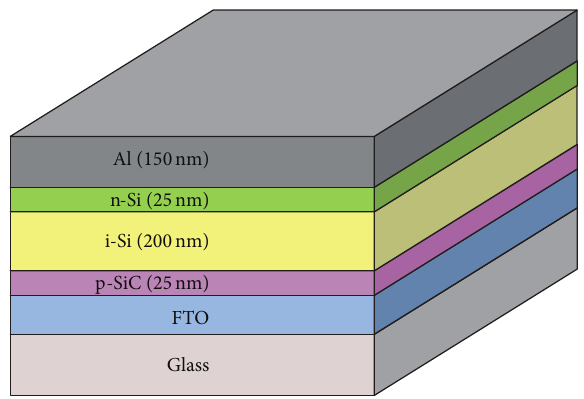
Figure 2: Schematic configuration of the p-SiC/i-Si/n-Si thin film solar